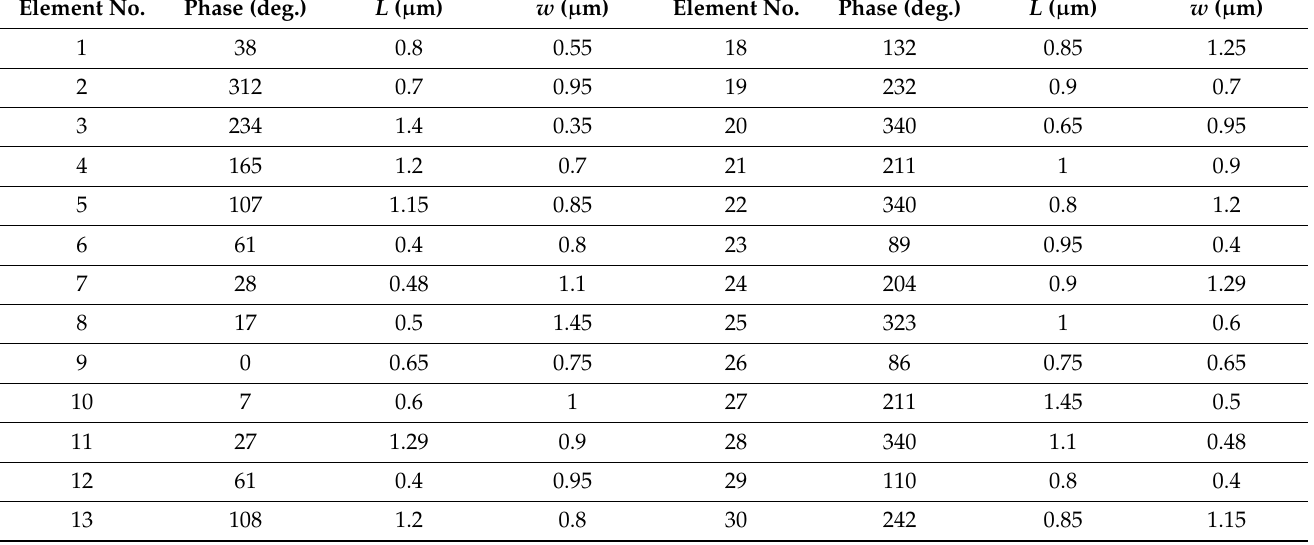
Table 1. The structural parameters and corresponding phases of each